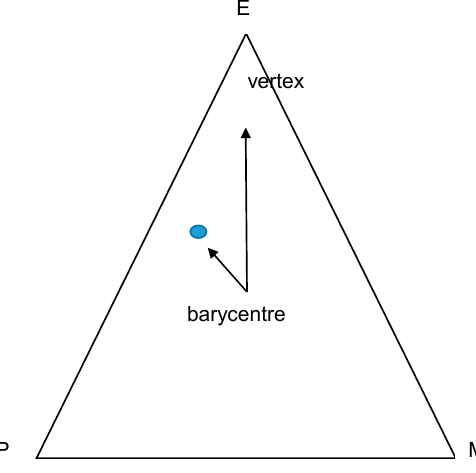
Figure 2. Simplex for three reply options ( P , E , M ).